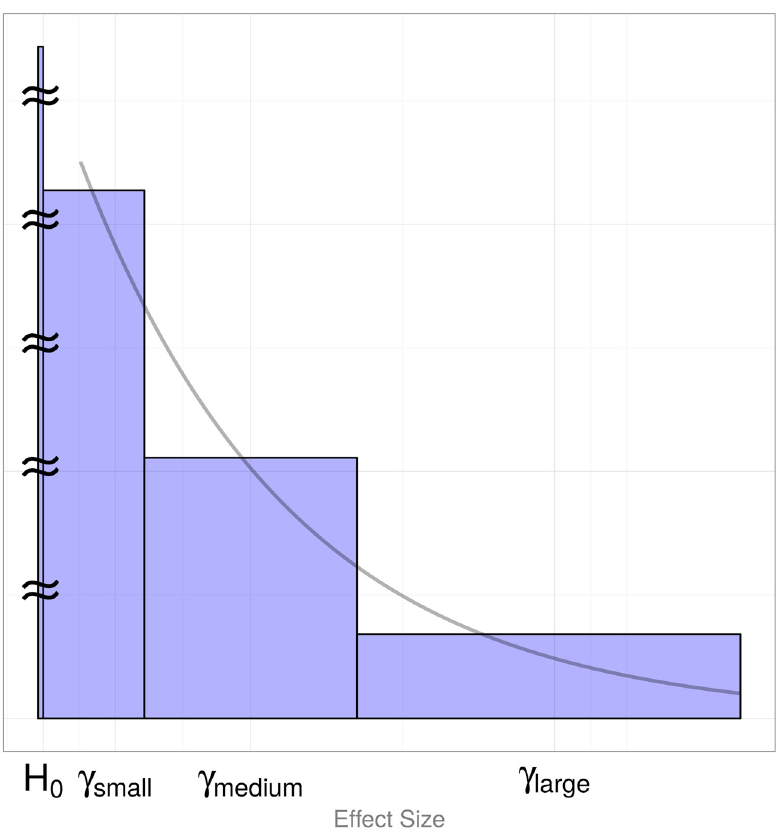
Fig 1. Approximating the effect size distribution by three values. Discretization of the Gamma(shape = 1, scale = 1) distribution. The middle bin is centered around γ medium = μ = scale×shape = 1 and has the width μ .